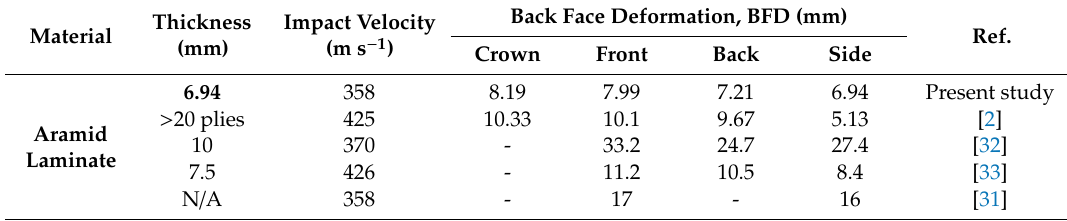
Figure 7. The time history of the BFD at different impact locations. Table 7. BFD of ballistic helmet obtained from simulation work.